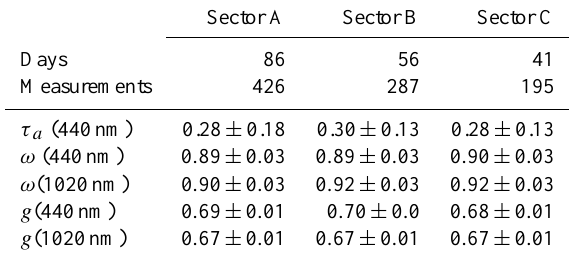
Table 1. The number of desert dust days, number of measurements recorded by sun photometer and the mean τ a ( λ) , ω(λ) and g ( λ) values for each sector A, B and